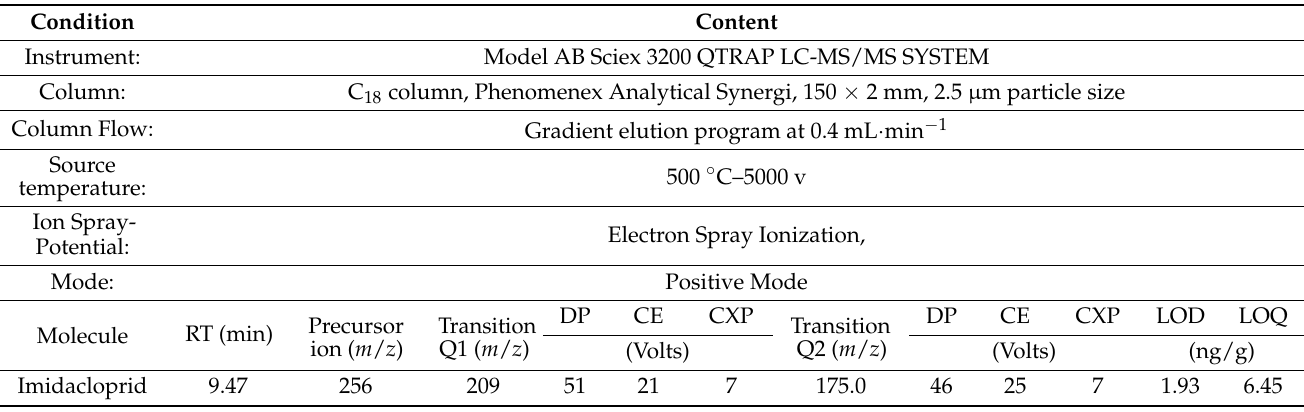
Table 4. Precursor, transition ions and source parameters for imidacloprid residues analyzed by the LC-MS/MS